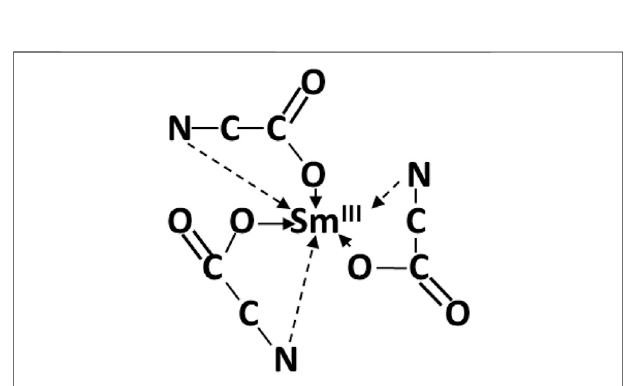
FIGURE 12 | Sm glycine chelate complexes adapted from Prados and Hadjipanayis (1999).